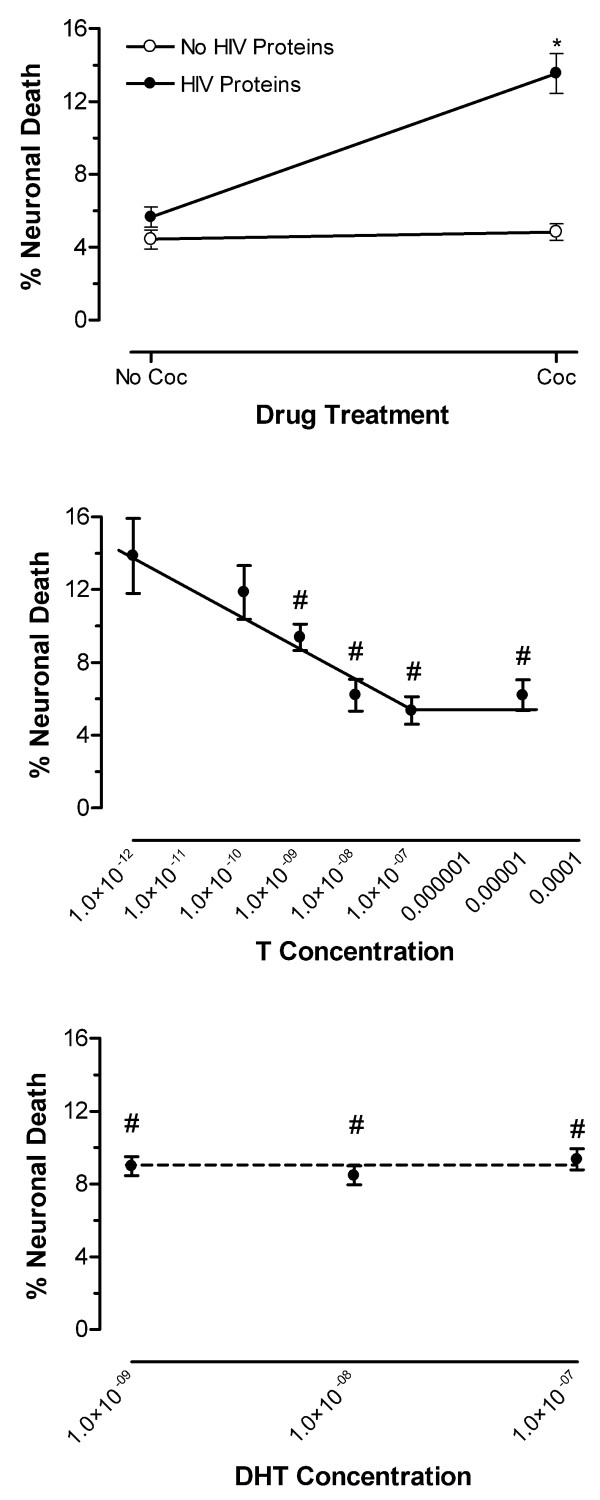
T [M] provides concentration-dependent neuroprotection against synergistic neurotoxicity of HIV proteins with cocaine (Coc); DHT's [M] neuroprotection is limited. Control conditions of incubation with Locke's Buffer vehicle or the HIV proteins or Coc only produced similar neuronal death. (Top Panel) Significant interaction of the HIV proteins with Coc, as illustrated by the lines diverging from parallel, produced toxic synergism (*p < 0.0087) (Middle Panel). T provides significant concentration-dependent neuroprotection against HIV proteins w/ Coc toxic synergism (#p < 0.0001). (Bottom Panel). DHT mediated partial protection against synergistic neurotoxicity of HIV proteins w/ Coc (#p < 0.023); however, the neuroprotection was not concentration dependent.